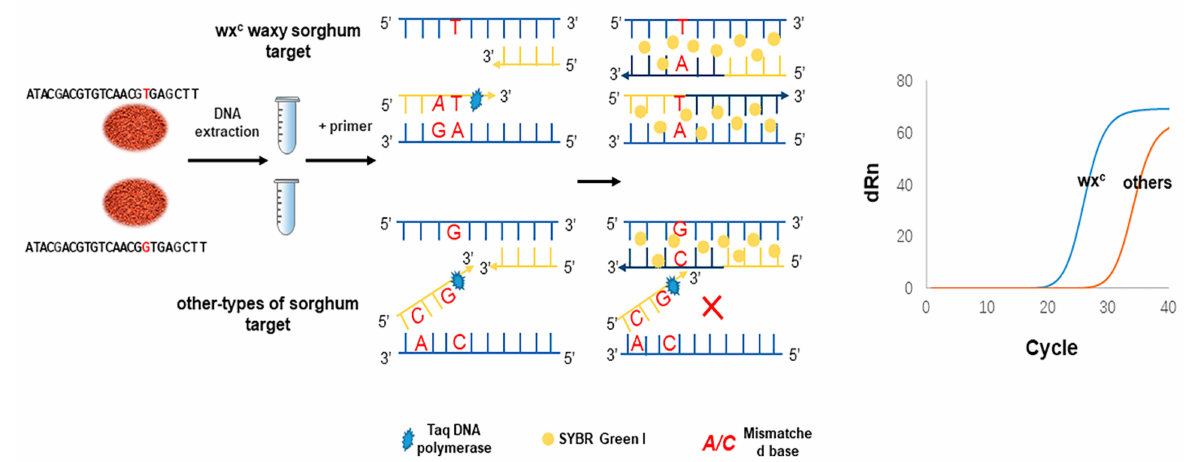
Scheme 1. Schematic illustration of the working principle of aARMS-PCR for distinguishing sorghum species with single-nucleotide